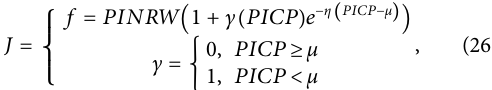
FIGURE 3 The relationship between the uncertainty sets X ( ) and Z (